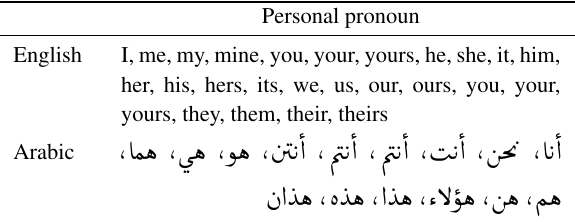
Table 8 Personal pronouns in English and Arabic.